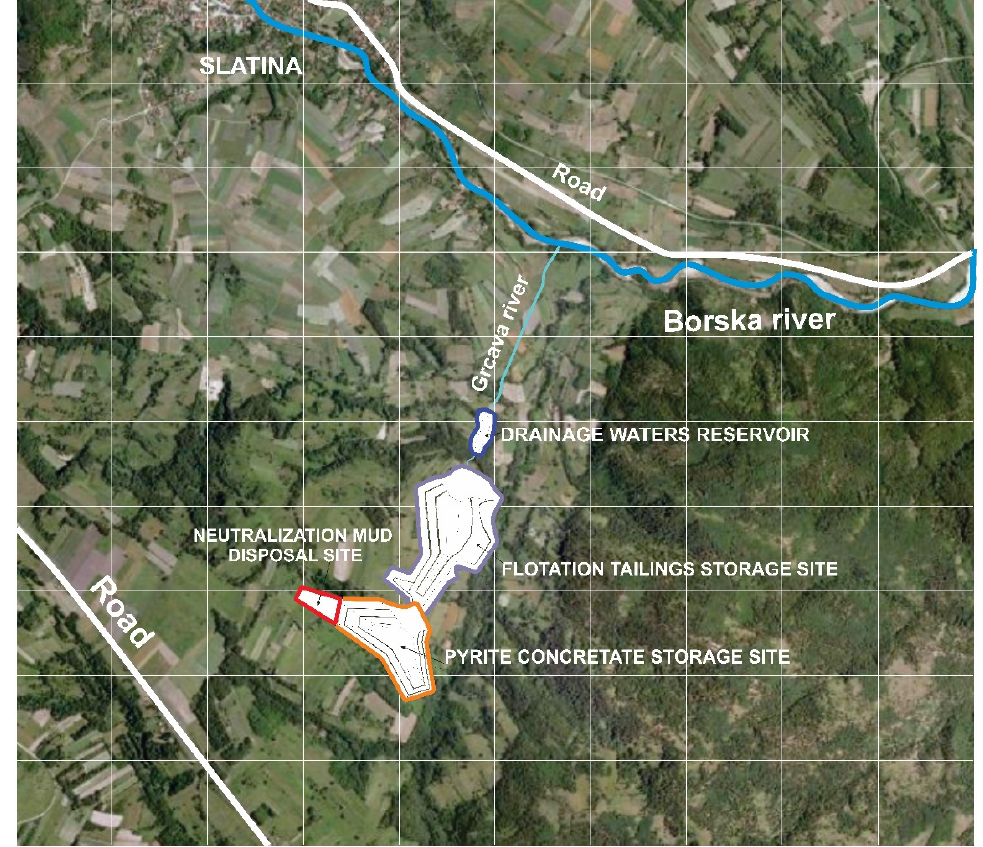
Figure 2. Outline of the Cukaru Peki deposit with its immediate surroundings (scale 1:10,000). The most upstream facility is the neutralization mud disposal site, where the pyrite concentrate storage site is connected, and followed by the flotation tailings storage site further on, which is the largest storage facility at the location in question. The last facility in the series is the drainage water reservoir